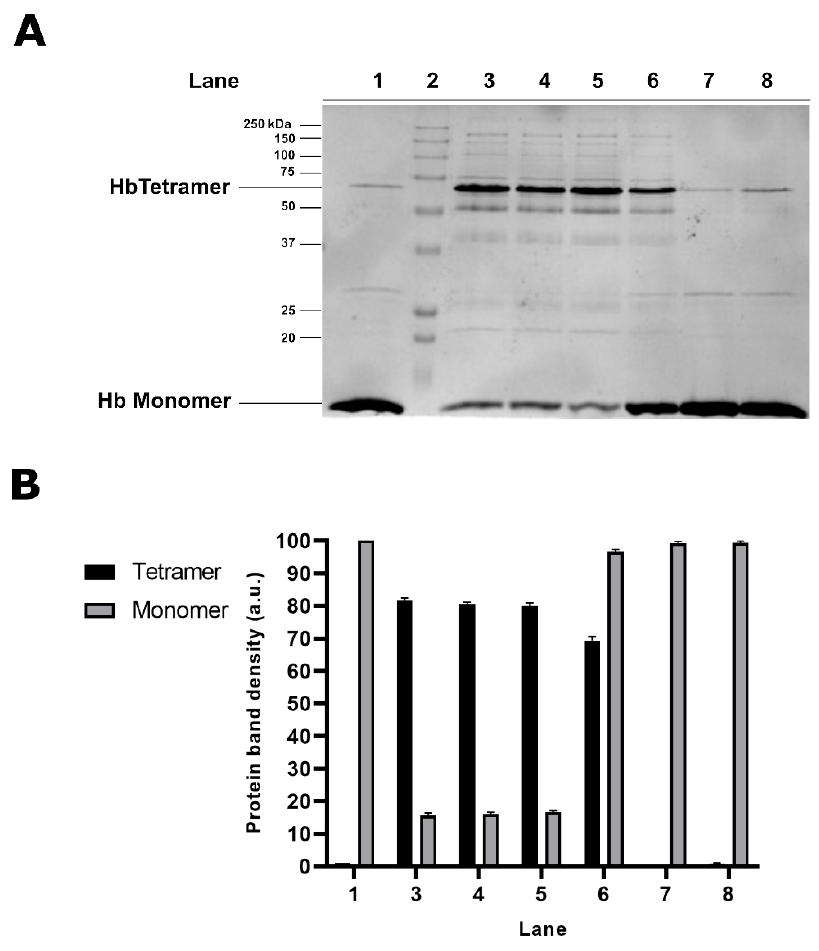
Figure 3. E ff ect of Dithiothreitol (DTT) on Hg-induced protein aggregates in human RBC. Intact RBC were treated with for 30 min with 30 mM DTT before and after cell exposure to with 1 µ M HgCl 2 and the cytosolic fractions analysed by SDS-PAGE. ( A ) Electrophoretic profile of samples from untreated RBC (lane 1) and from cells exposed to 1 µ M HgCl 2 (lanes 3–5); MW markers (lane 2); samples from RBC treated with HgCl 2 and then with DTT (lane 6); Hb from RBC treated only with DTT (lane 7); Hb from RBC treated with DTT and then with HgCl 2 (lane 8). ( B ) Densitometric analysis of the 16 and 64 kDa protein bands. The values shown are relative to n = 5 repeats.